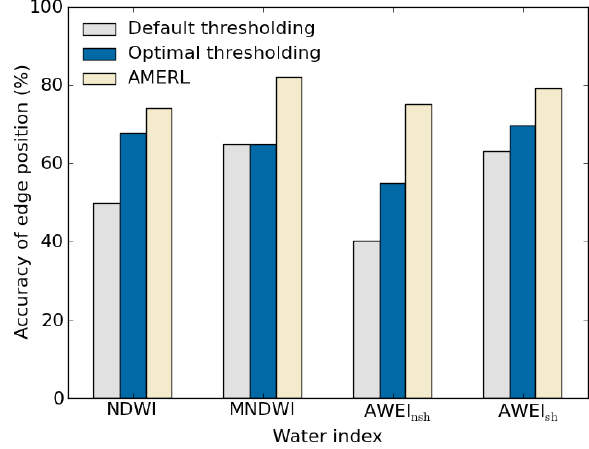
Figure 9. The edge extraction accuracy for Panjiakou Reservoir using the three methods in study Area